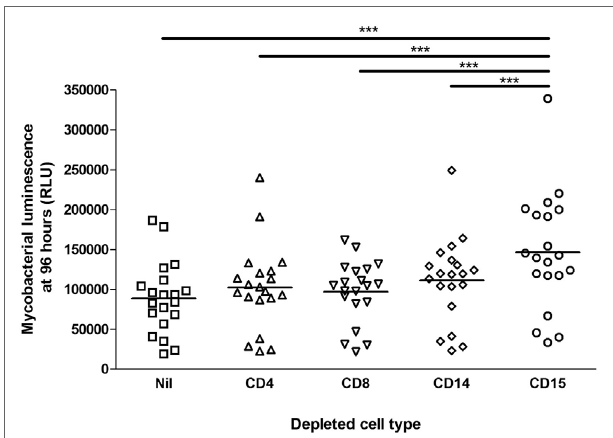
FigUre 1 | Impact of cell depletions on control of mycobacterial luminescence in whole blood. Blood was taken from 20 donors. 450 mcl of blood depleted of CD4 + , CD8 + , CD14 + , CD15 + or no cells (in triplicate per donor per condition), diluted 1:1 with RPMI-1640, was infected with approximately 5 × 10 5 CFU Mycobacterium tuberculosis -lux in 100 mcl PBS. Samples were incubated on a rocking plate (20 rpm) at 37°C for 96 h before removal of supernatants, lysis of red blood cells with water, resuspension in 1 ml PBS and measurement of mycobacterial luminescence on at least two 100 mcl aliquots. Results presented are the mean of all measurements across triplicate samples for the relevant condition. *** p < 0.001 (one-way